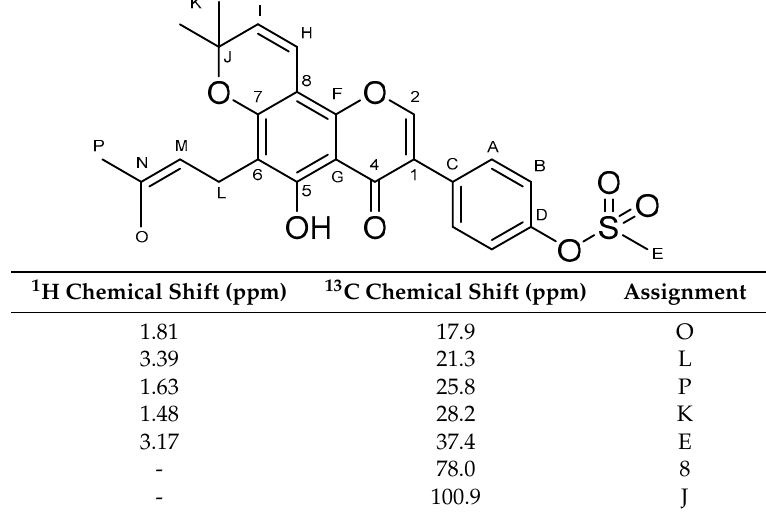
Table 1. 1 H and 13 C-nuclear magnetic spectroscopy (NMR) chemical shifts and structure of 2 .